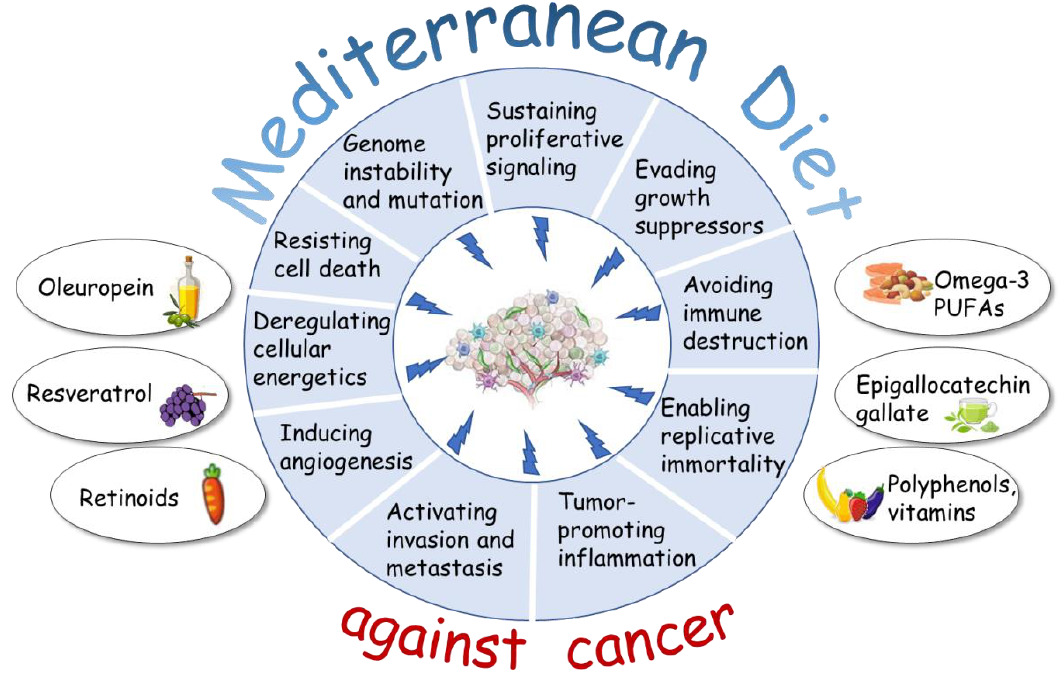
Figure 1. Schematic representation of the molecular mechanisms by which Mediterranean Diet (MD) pattern may impact on hallmarks of cancer. Foods of the MD, including olive oil, red wine, fruits, legumes and vegetables, contains bioactive molecules such as oleuropein, resveratrol, retinoids, vitamins, epigallocatechin-gallate and omega-3 polyunsaturated fatty acids (PUFAs), that exert anti-tumoral activities by targeting the various hallmarks of cancer.